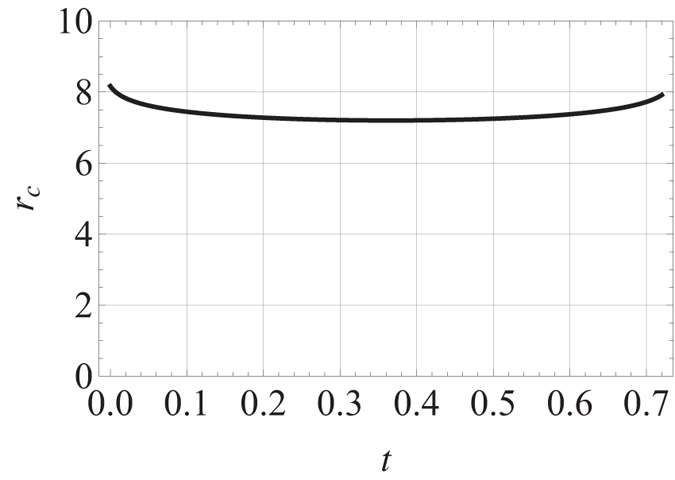
Position of sonic horizon rc (based onEq. (20)) vs.  in units of (/mΩ)1/2 for ai = 200a0, af = 5ai.